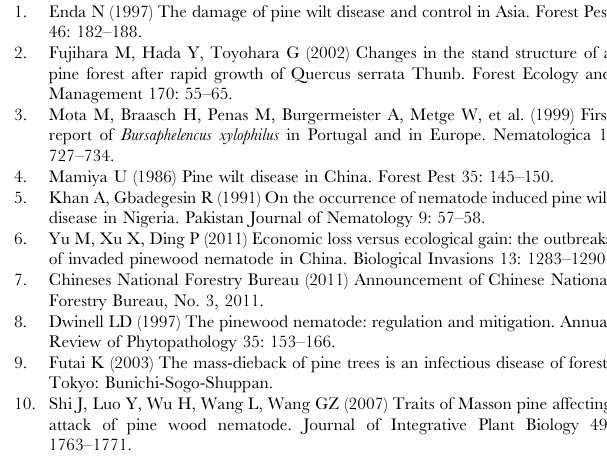
Table S1 Plant species list of four study sites. (DOCX)